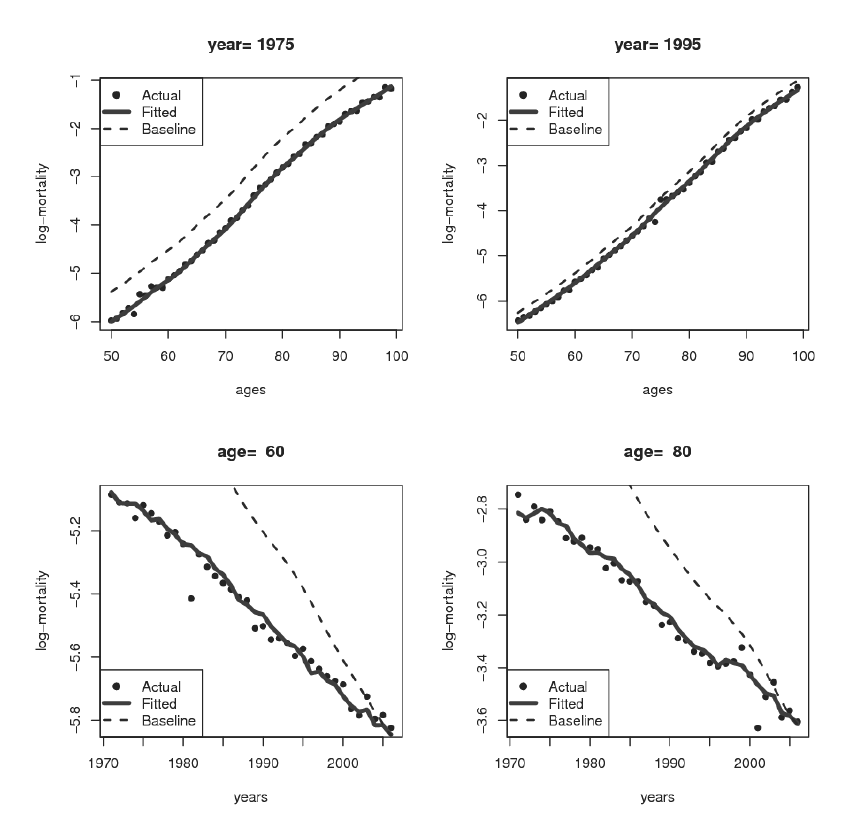
Figura 5 – Observed and fitted mortality rates for selected years and ages. Ip = H and Ic = m 0 . Italy,